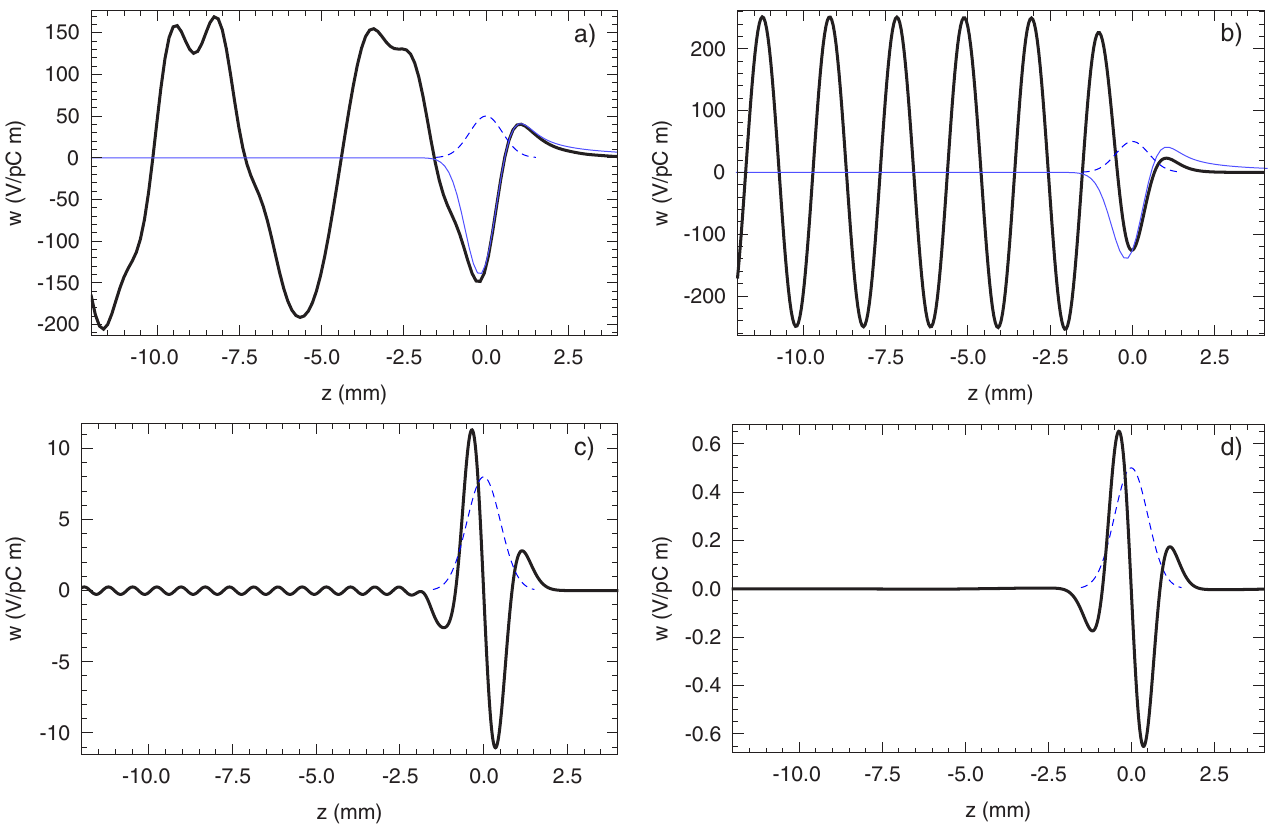
FIG. 5. (Color) Steady state wakefields in the toroid for the aspect ratio A ¼ 0 : 5 and various values of b : (a) b ¼ 4 cm , (b) b ¼ 2 cm ,